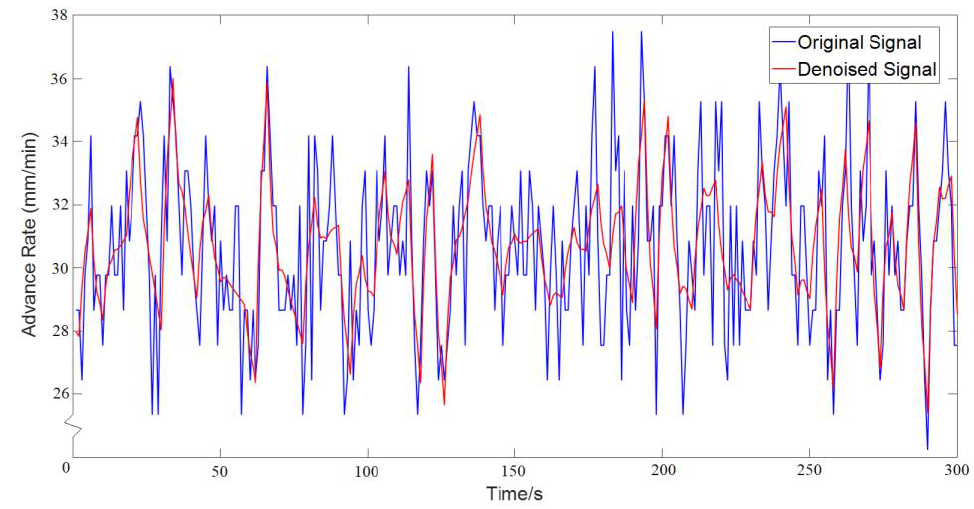
Figure 7. Original and denoised TBM advance rate.